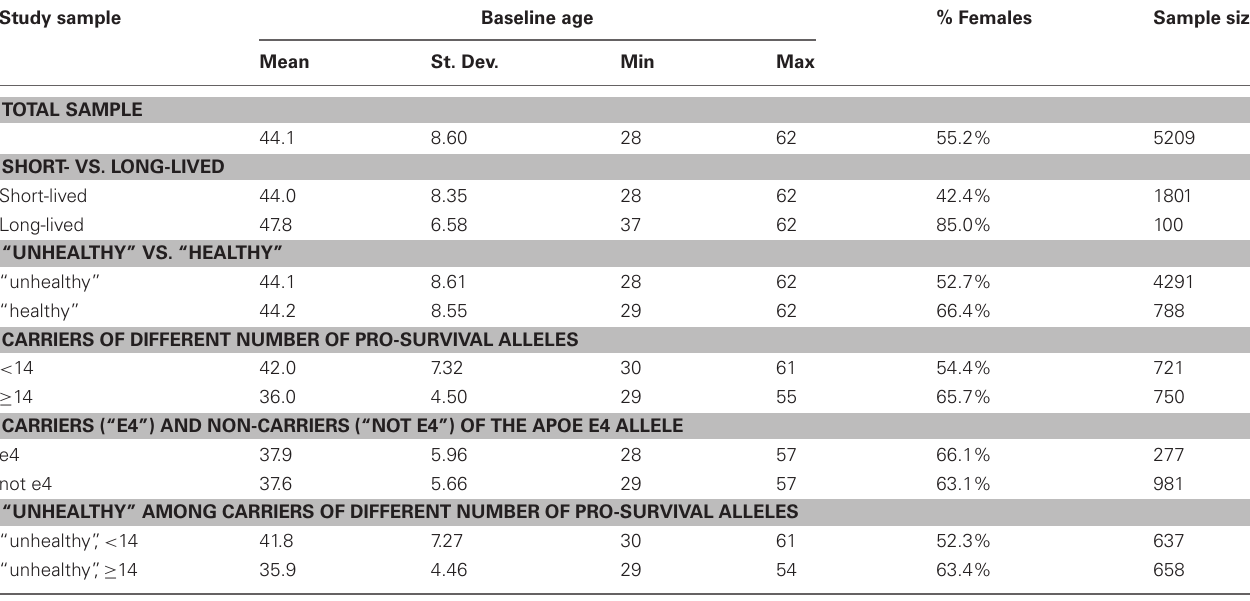
Table 2 | Characteristics of study